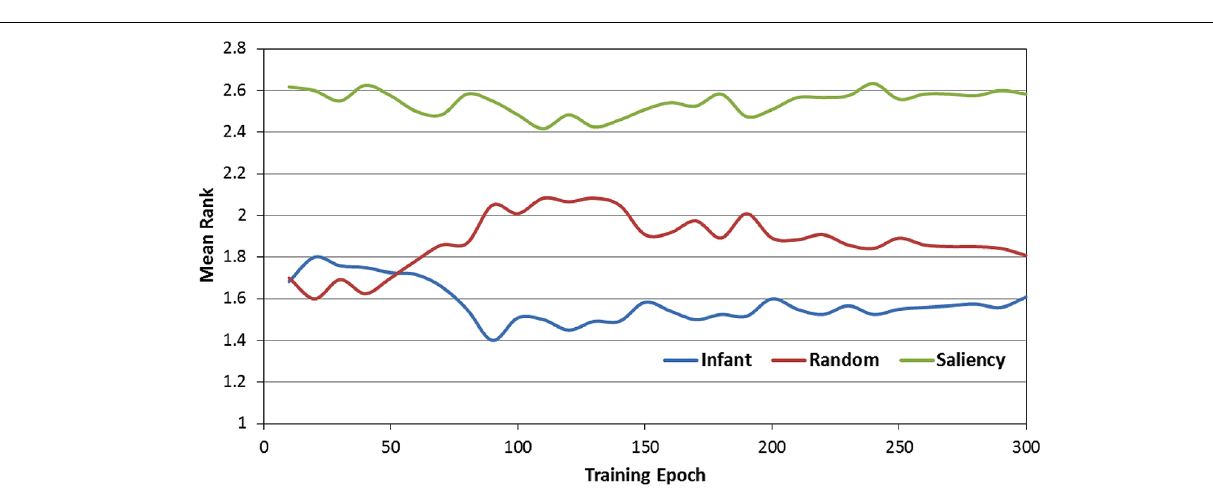
FIGURE 5 | Mean rank scores over the 300 training epochs, as a function of the three observer